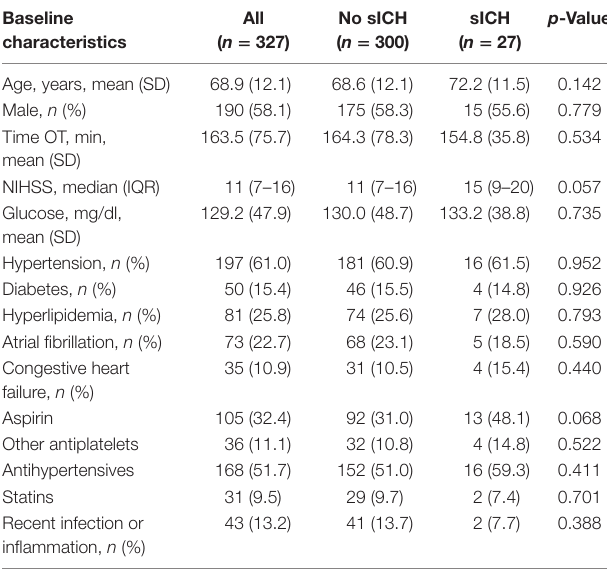
TaBle 1 | Baseline characteristic of the 327 enrolled